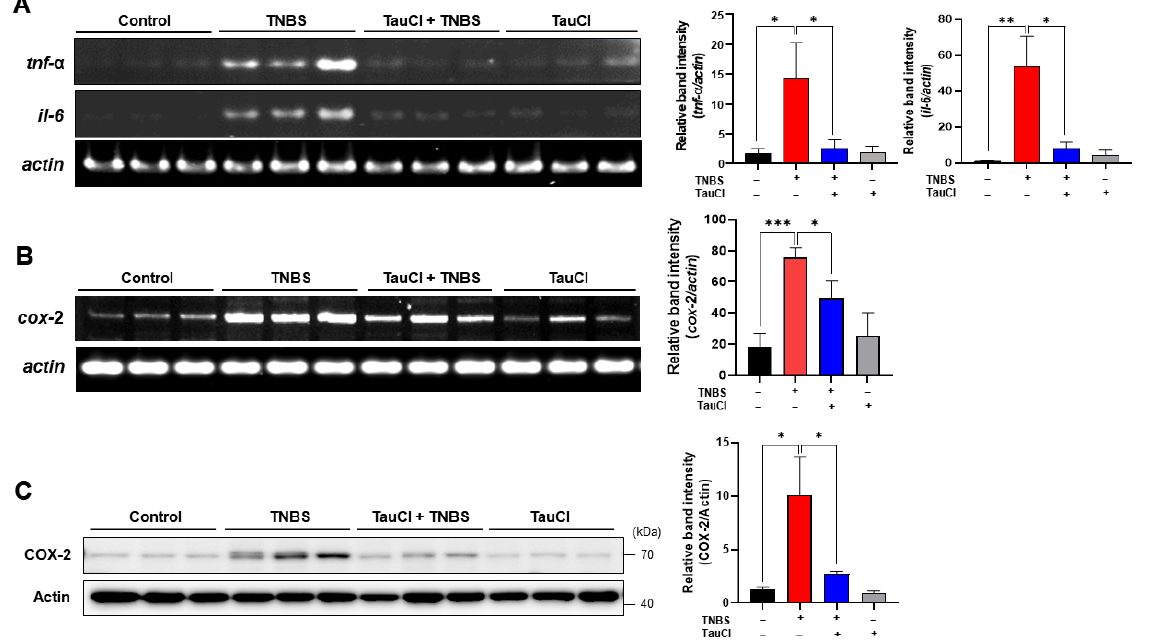
Figure 3. Effects of TauCl administration on expression of proinflammatory cytokines and COX-2 in mouse colonic mucosa. ( A ) RT-PCR analysis of mRNA expression of proinflammatory cyokines ( tnf- α , il-6 ) and cox-2 . ( B , C ) Colonic expression of cox-2 and COX-2 expression was assessed by RT-PCR and Western blot analysis, respectively. Data are expressed as means ± SD ( n = 3 for each group). * , ** , *** Significantly different between groups compared (* p < 0.05; ** p < 0.01; *** p < 0.001).